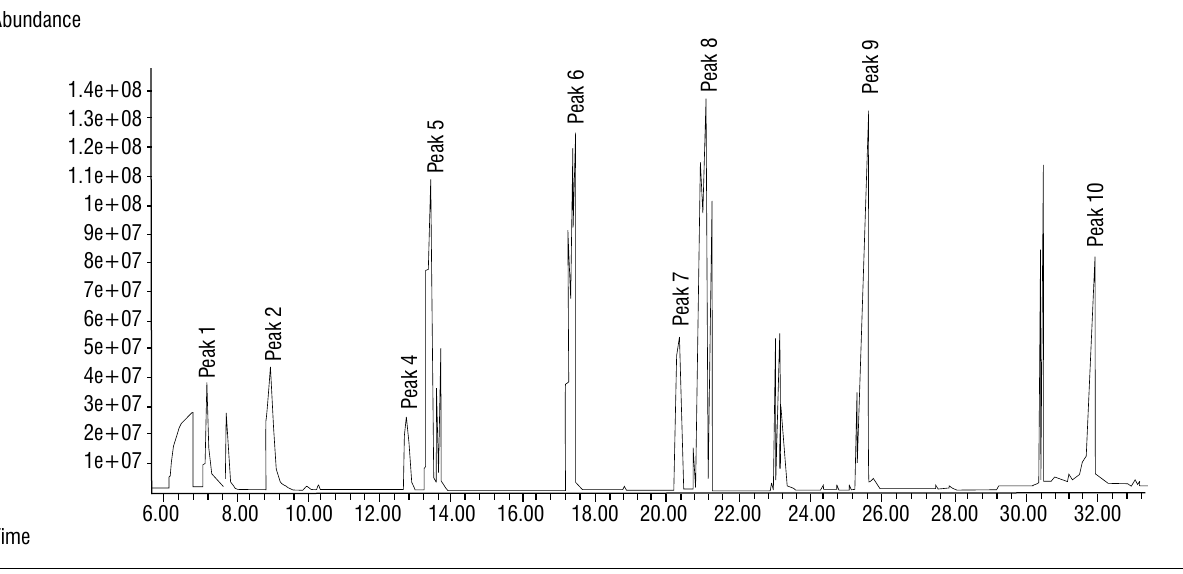
Figure 1: Gas chromatography–mass spectrometry (full scan) chromatogram showing the peaks corresponding to compounds present in the garlic extract in relation to retention time: peak 1, dimethyl disulphide; peak 2, diallyl sulphide; peaks 3 and 4, allyl methyl sulphide; peak 5, allyl methyl disulphide; peak 6, dimethyl trisulphide; peak 7, 1-oxa-4,6-diazacyclooctane-5-thione; peak 8, diallyl disulphide; peak 9, allyl methyl trisulphide; peak 10, diallyl